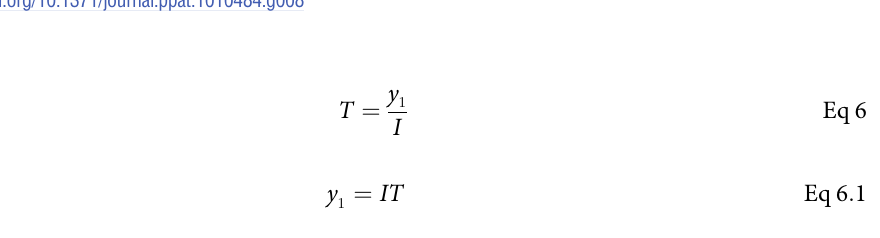
Fig 8. Gm NPV Pathogenic Potential . The pathogenic potential of the Gm NPV (nuclear polyhedrosis virus) was calculated from published values [29,30]and plotted against inoculum. There is a negative exponential relationship between the amount of virus used to infect G . mellonella and the pathogenic potential in the Stairs 1965 study. In the Fraser and Stairs 1982 study, the relationship is varied, where the lower inocula have a positive exponential relationship with pathogenic potential, and the higher inocula have a negative exponential relationship with PP. Both plots are fitted with an exponential one phase decay function.